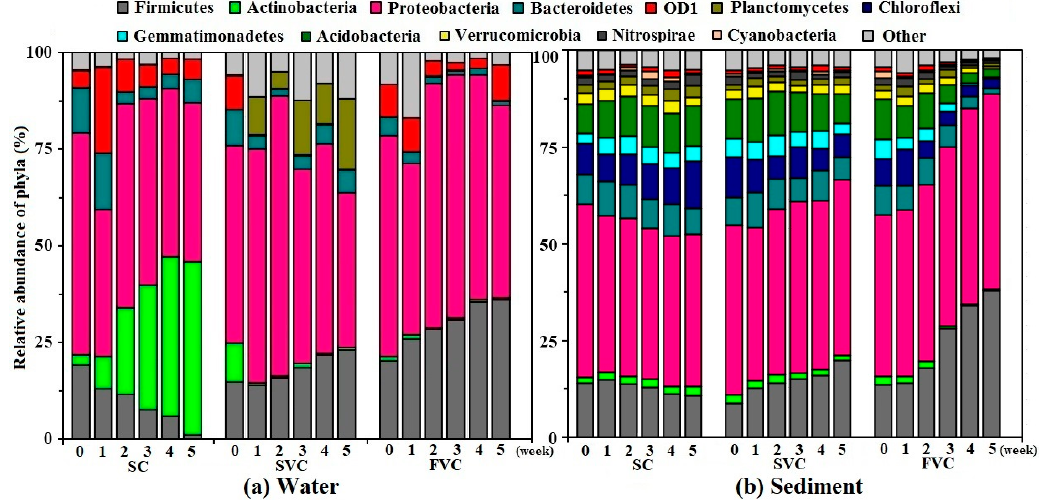
Figure 4. Relative abundance of bacterial reads classified at phylum level along the timescale (weeks 0–5) obtained from Ribosomal Database Project (RDP) classifier analysis (mean relative abundance > 1.0%). ( a ) Water, ( b ) Sediment. SC: static control, SVC: slow velocity condition, FVC: fast velocity condition.